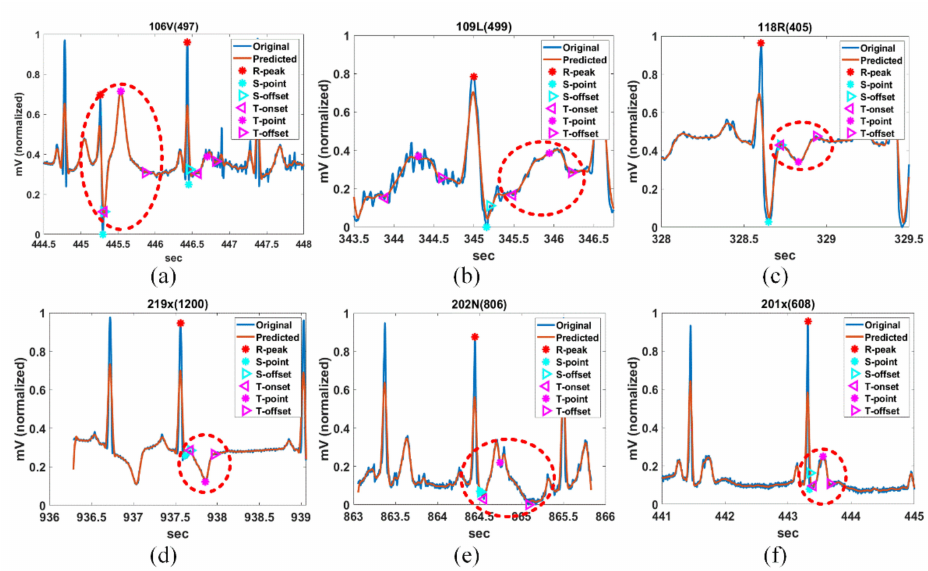
Figure 12. Detection of abnormal T-waves for ( a ) 106V(497), ( b ) 109L(499), ( c ) 118R(405), ( d ) 201x(608), ( e ) 202N(806), and ( f ) 201x(608) in MIT-DB.